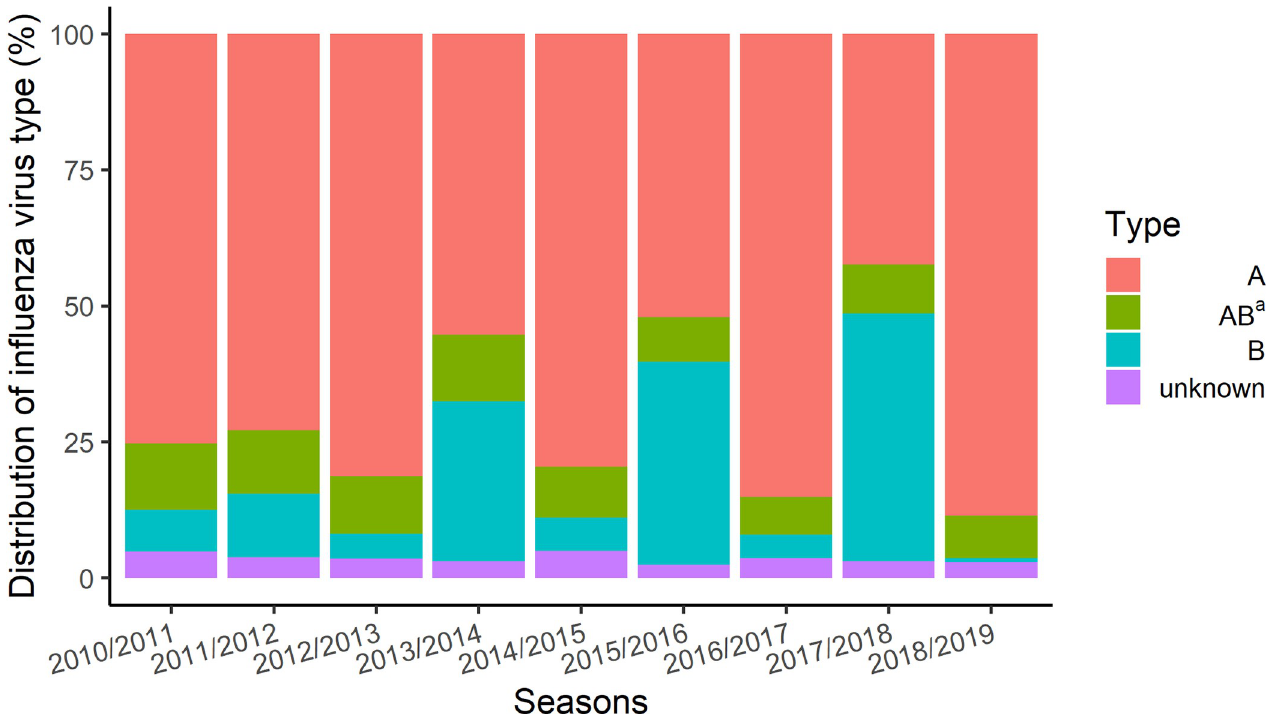
Fig 3. Distribution of influenza virus type among medically-attended patients with laboratory-confirmed influenza, by influenza season (2010/2011– 2018/2019). a AB; Patients who recorded with both types A and B positive influenza test result on the same inedex date (co-detection).